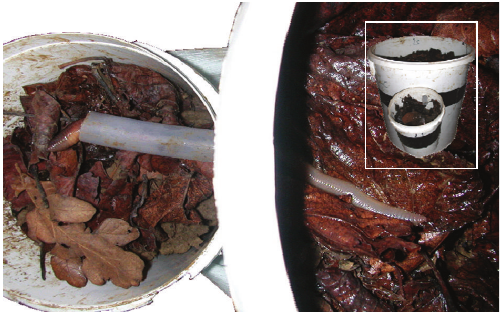
Figure 2: Plan view of a tunnel trap showing a mature L. terrestris exiting a 20-litre mesocosm into the attached 1-litre capture pot (lids removed). Insert shows a lateral view of the whole